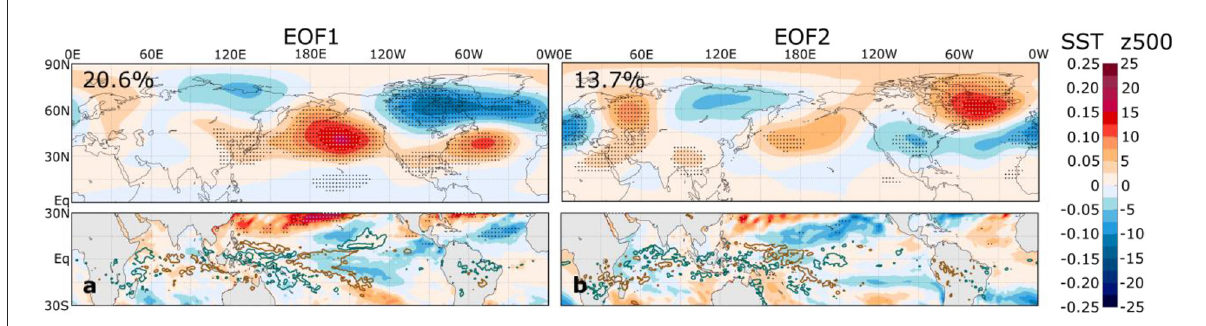
FIGURE8 Linear regressions of simulated z500 (top panels, color shading, units of m), SST (bottom panels, color shading, units of ◦ C), and precipitation anomalies (bottom panels, green contours at values of 0.2 and 0.5mm day − 1 and brown contours at values of − 0.2 and − 0.5mm day − 1 ) on the standardized principal components of the (a) first and (b) second EOFs of DJF El Niño 1951–2000 z500 composite anomalies. Stippling in the top (bottom) panels indicates statistically significant z500 (SST) regression coefficients that control the false discovery rate at the 10% level based on an F -test. The percentages at the top left of each upper panel indicate the amount of variance explained by the